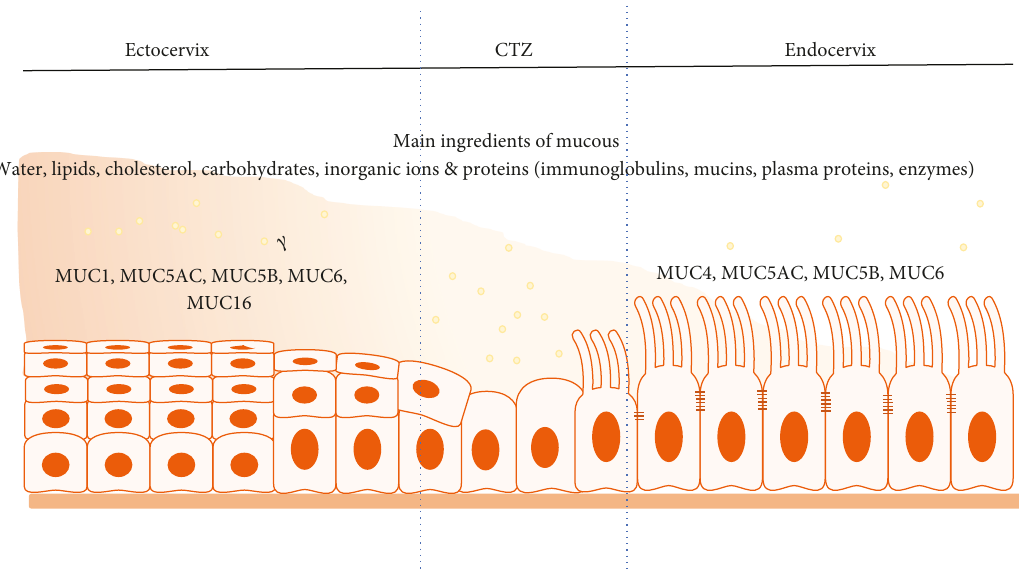
Figure 4: Pro fi le and distribution of cervical mucus. This fi gure shows the main ingredients of cervical mucus and common and distinct distribution of mucin in the ecto- and endocervix. Mucus provides a physical and chemical barrier against pathogens.